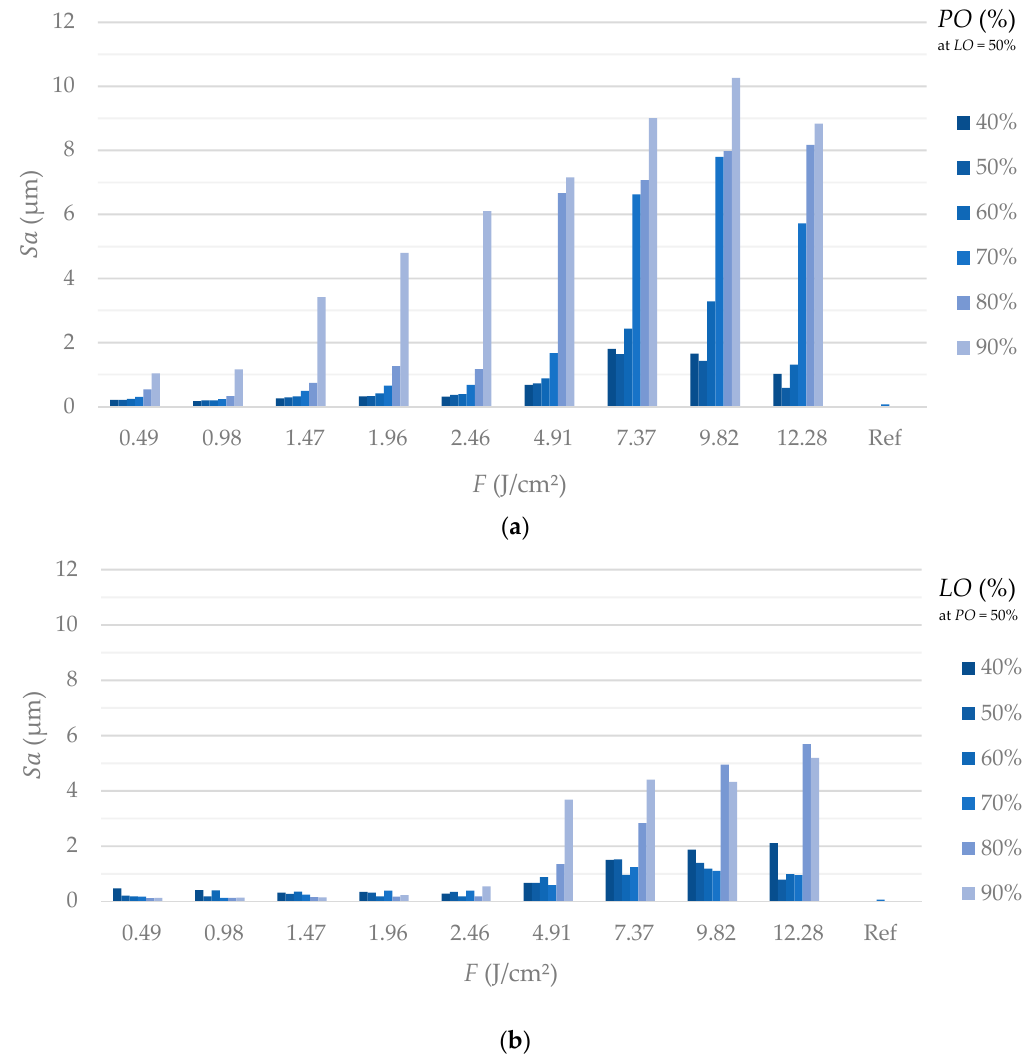
Figure 7. Average area surface roughness ( Sa ) after laser processing related to the reference (Ref). ( a ) A clear increase of the roughness can be obtained with increasing PO at all fluences. ( b ) A higher scanning line overlap leads also to an increase in roughness above a fluence of approx. 4.91 J/cm². Firstly, a higher LO leads to a decreased roughness at low fluences. Generally, the determined average area surface roughness is less compared to that obtained at corresponding levels of PO (and the same energy input). At fluences from 7.37 J/cm² to 12.28 J/cm², a minor increase in roughness can be detected at a low level of LO due to a clear trench formation.